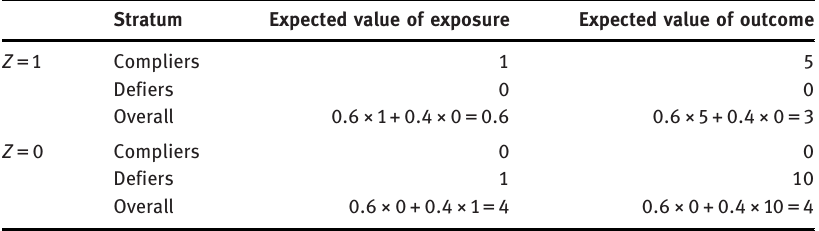
Table 1: Example 1: effect heterogeneity and non-monotonicity. Instrumental variable estimate = − 5, despite positive causal effect for all is 3 − 4 0.6 − 0.4